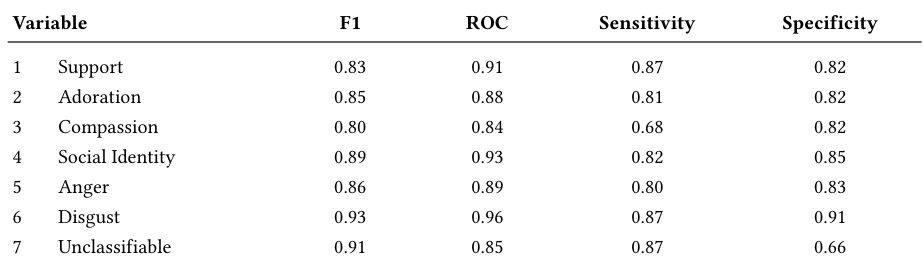
Model Performance for Variables of